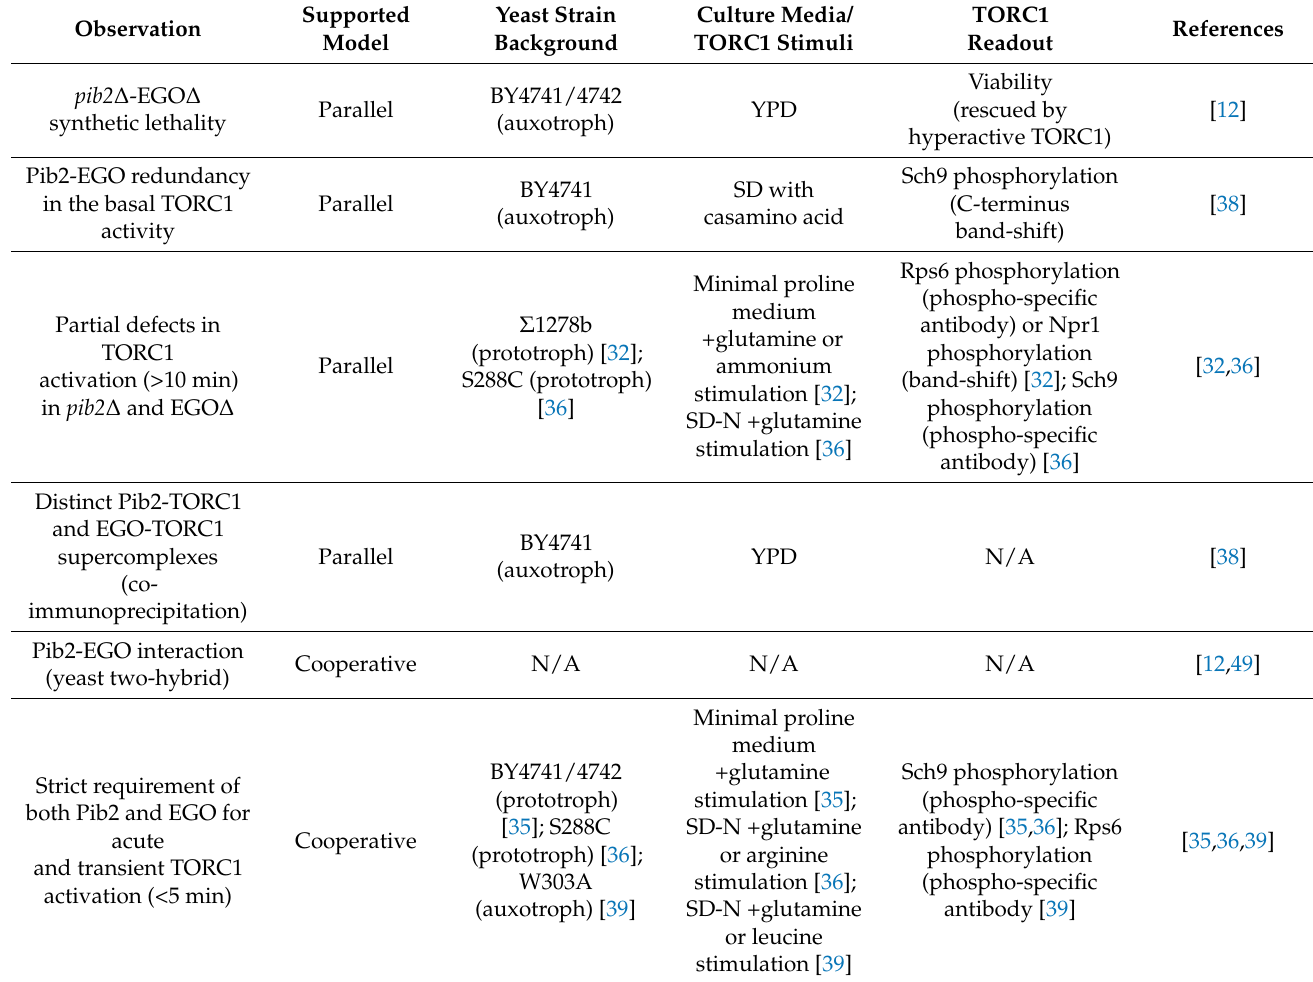
Table 1. Observations supporting either the Pib2-EGO parallel or cooperative